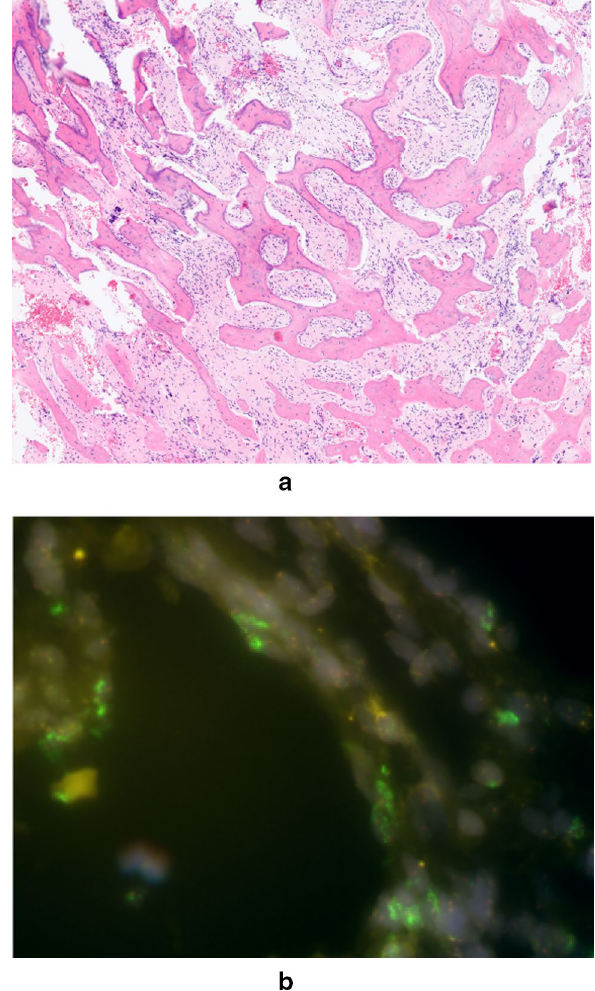
Fig. 4 a HE stains showing a slightly pleomorphic matrix- forming tumor with promi- nent capillarization. b FISH analysis of the osteosarcoma- tous component with clusters of MDM2